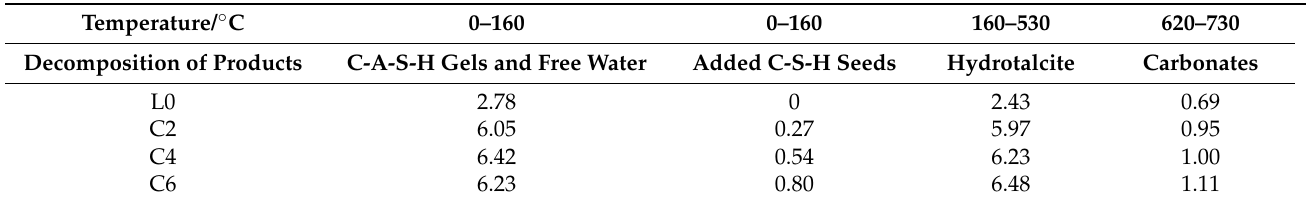
Table 2. Mass loss of hydration products as a function of temperature after 1 d of curing